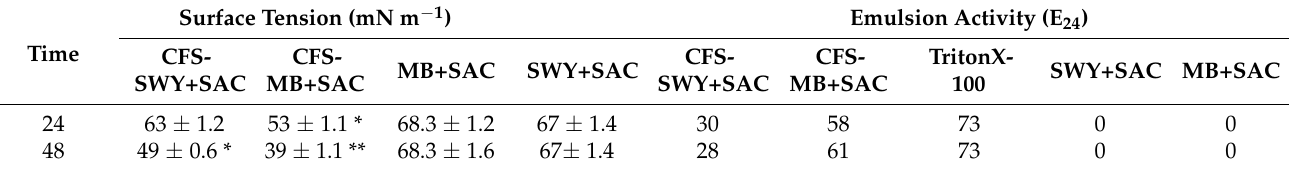
Table 1. Surface tension of cell-free supernatant (CFS) from SBP3 strain, grown in seawater plus yeast extract and 3% saccharose (SWY+SAC), or marine broth plus 3% saccharose (MB+SAC); * significantly different ( p < 0.05); ** p < 0.01.